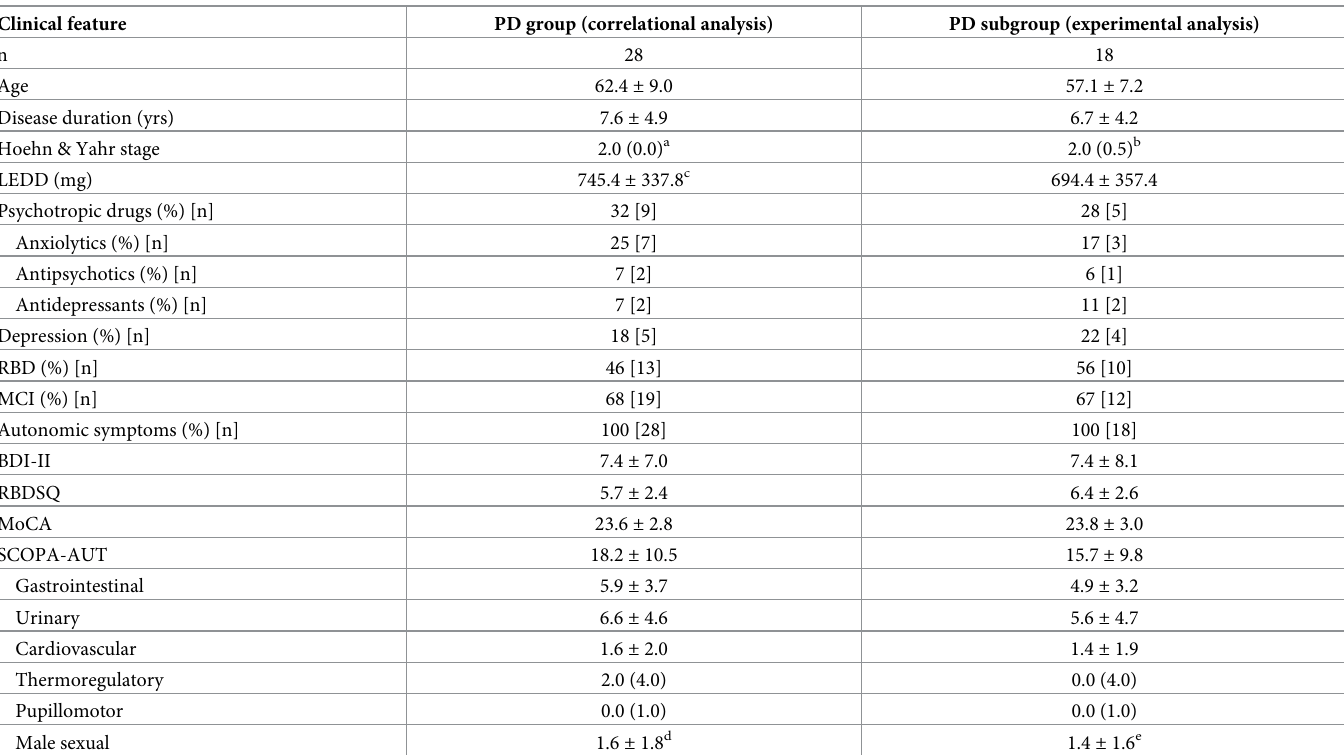
Table 3. Clinical characteristics of Parkinson’s disease